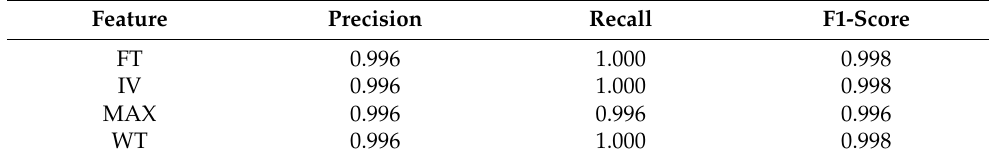
Table 4. Classification of exhaled gas after drinking by the RF classification model of each feature.